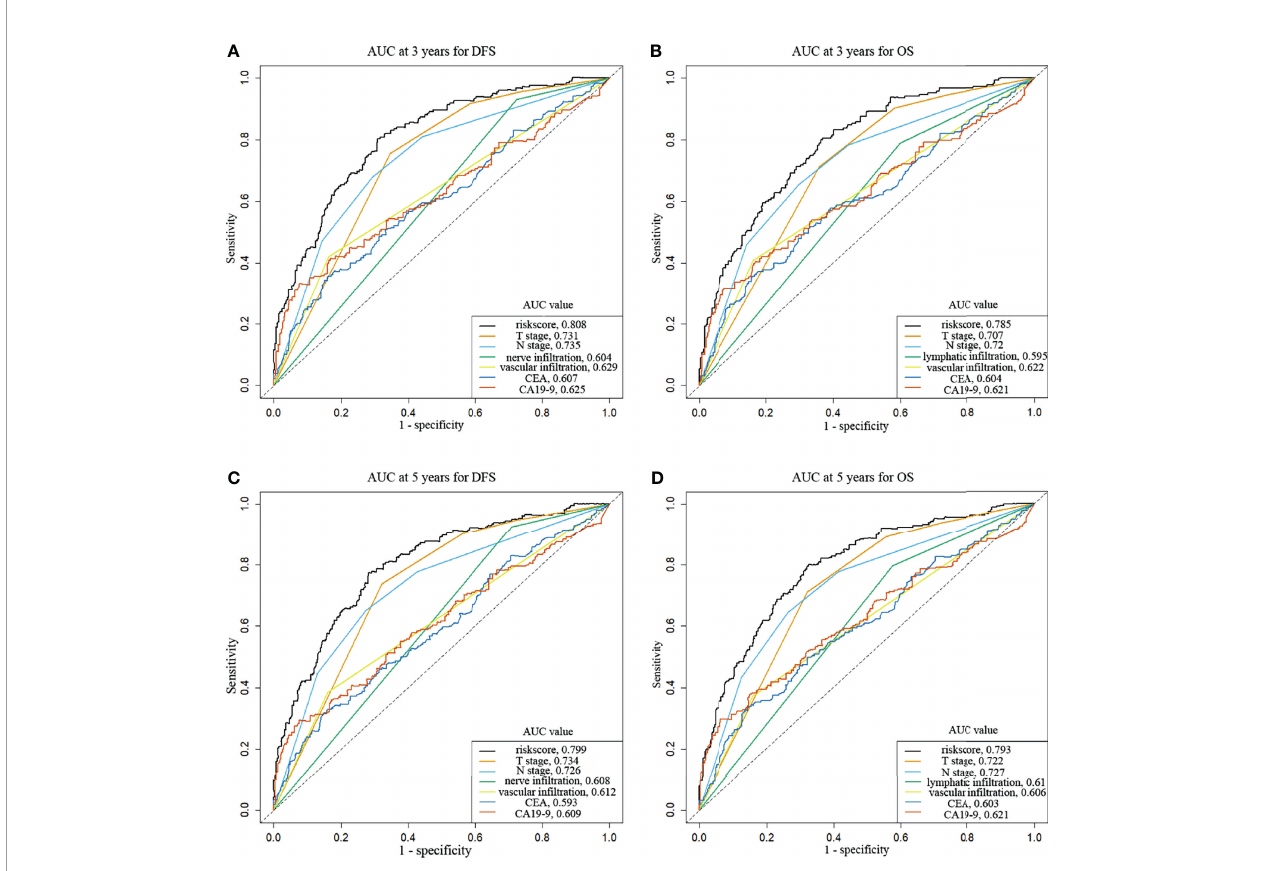
FIGURE 4 | Time-dependent receiver operating characteristic curves show the predictive accuracy of the signatures. (A) AUC curves at 3 years for DFS. (B) AUC curves at 3 years for OS. (C) AUC curves at 5 years for DFS. (D) AUC curves at 5 years for